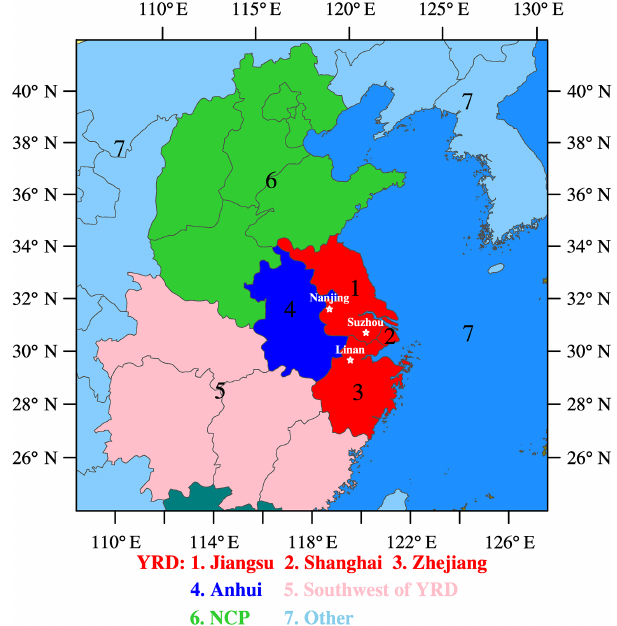
Figure 1. Modelling domain and source regions. White stars denote the locations of observation sites in Nanjing, Suzhou, and